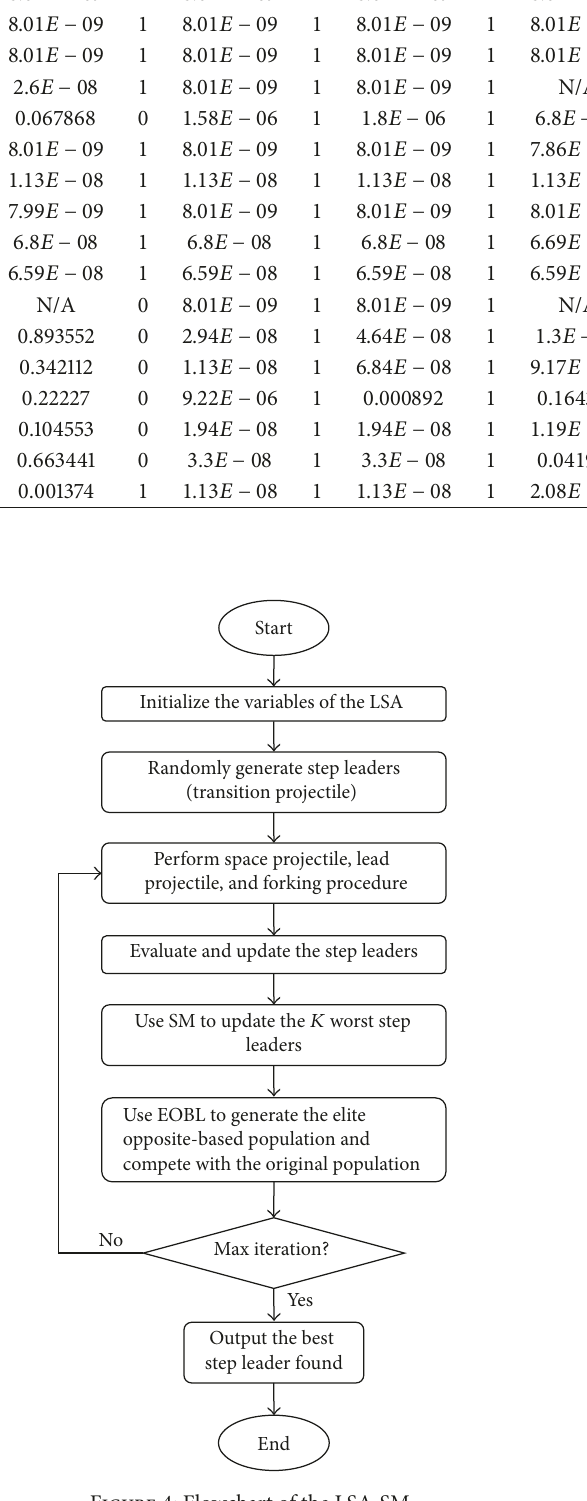
Figure 4: Flowchart of the LSA-SM.